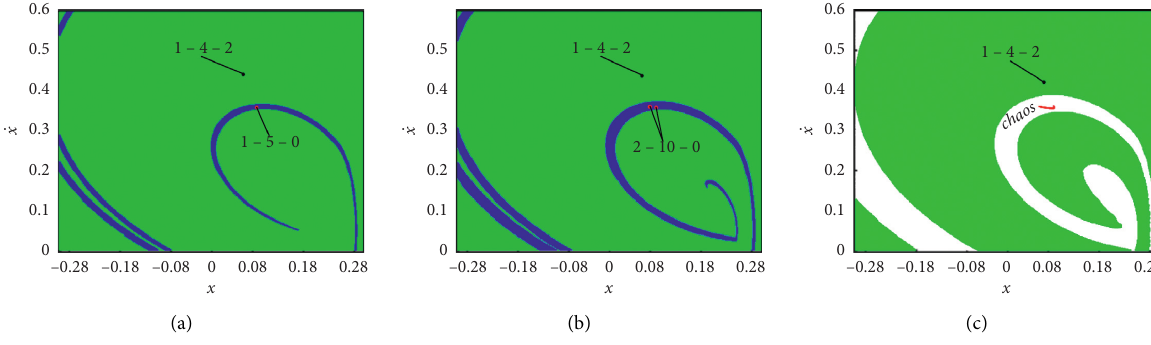
Figure 12: The attraction domain on the phase-fixed surface Σ